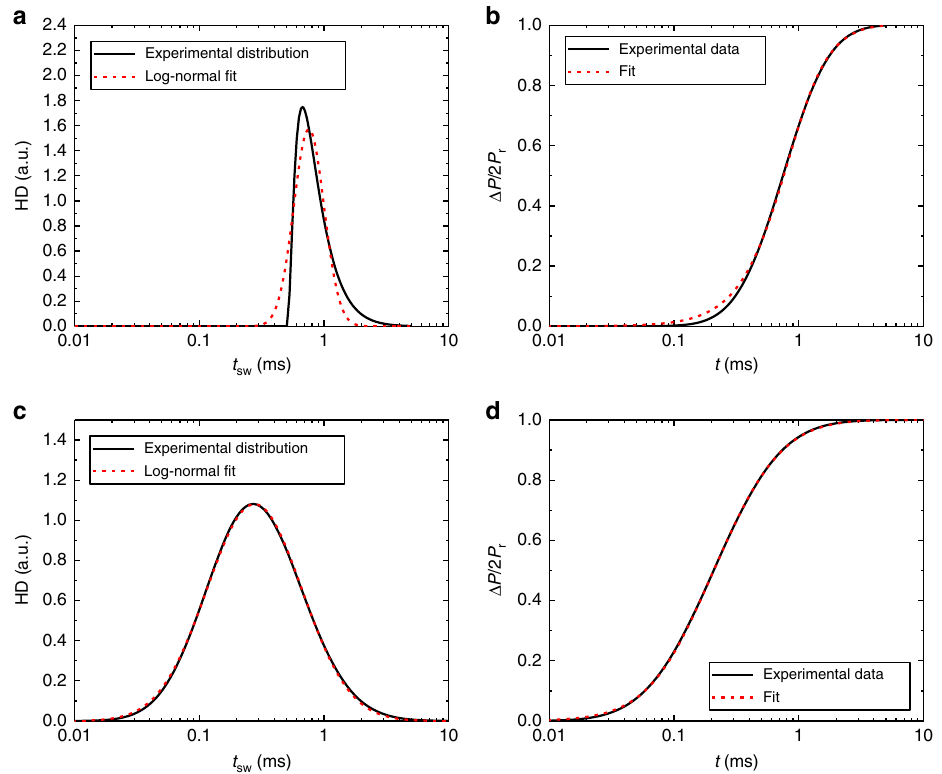
Fig. 7 Extracted total switching time distributions. The distributions are obtained from the convolution of experimentally obtained switching time dependence on Preisach coordinates and corresponding experimental Preisach distribution for a BTA and c P(VDF-TrFE), and a lognormal distribution fi tted to that (red dashed line). The resulting distributions are used to fi t the experimental macroscopic switching kinetics that are plotted in an integrated form in panel b for BTA and panel d for P(VDF-TrFE). The fi t parameters can be found in Supplementary Table